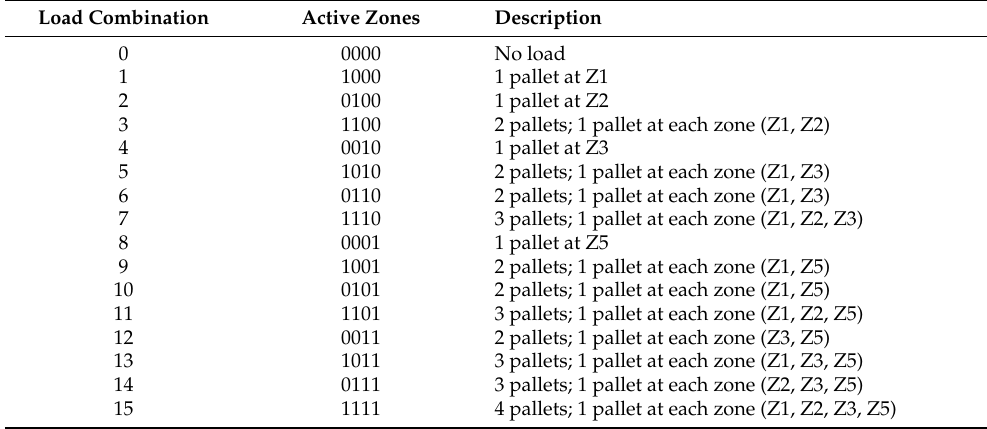
Table 2. Pallet position on main conveyor’s zones with respect to load combinations.